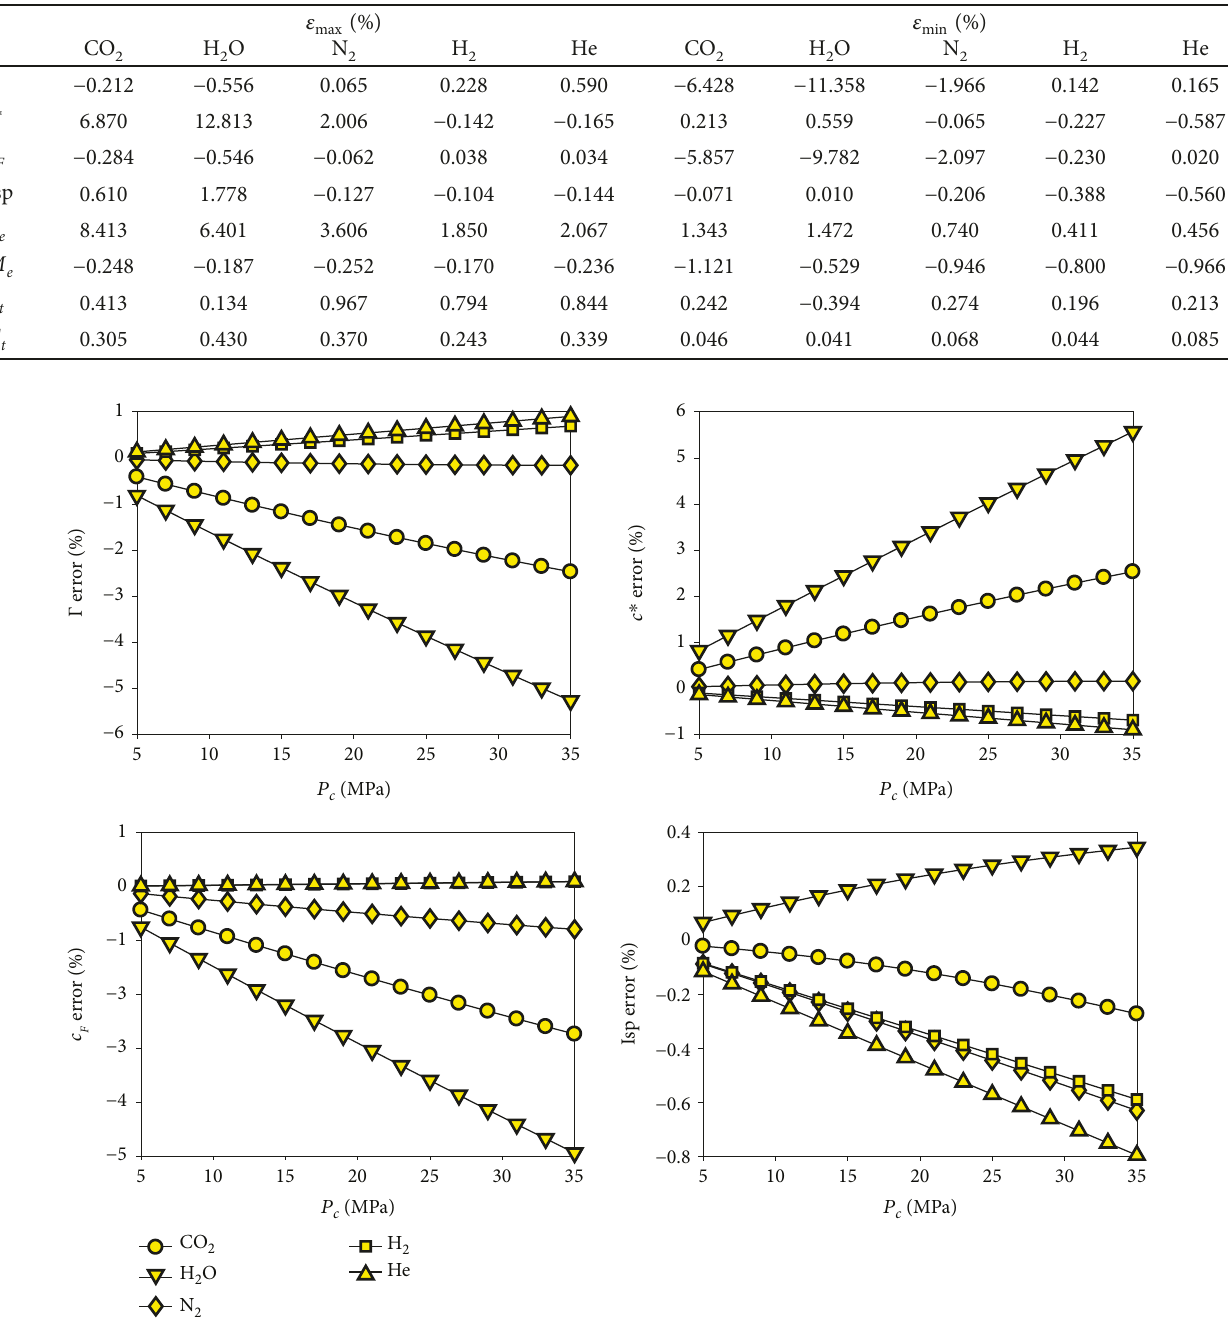
Table 4: Maximum and minimum error values of propulsion and fl ow parameters of thermally perfect ideal gases for P K – 4000K and frozen fl ow expansion in vacuum with A